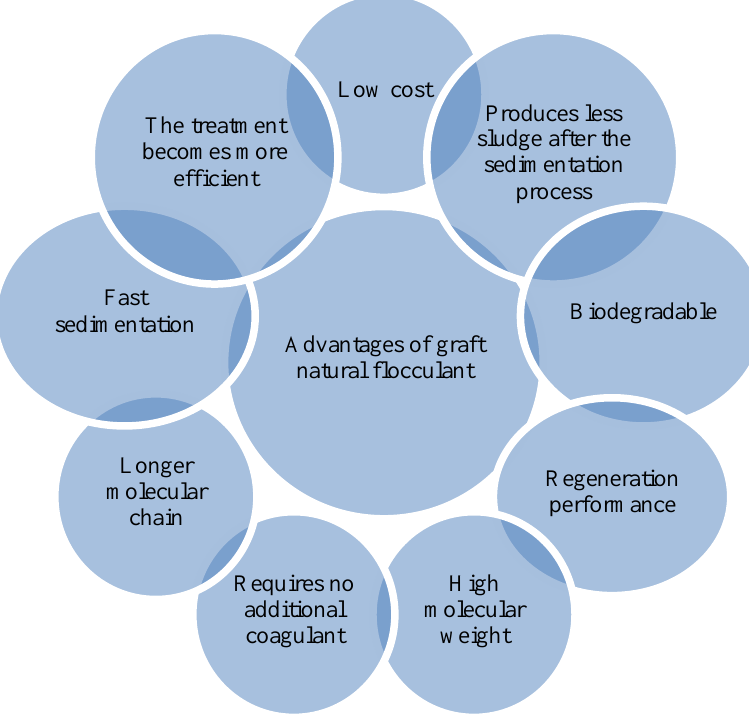
Figure 1. Benefits of grafting a natural polymer.